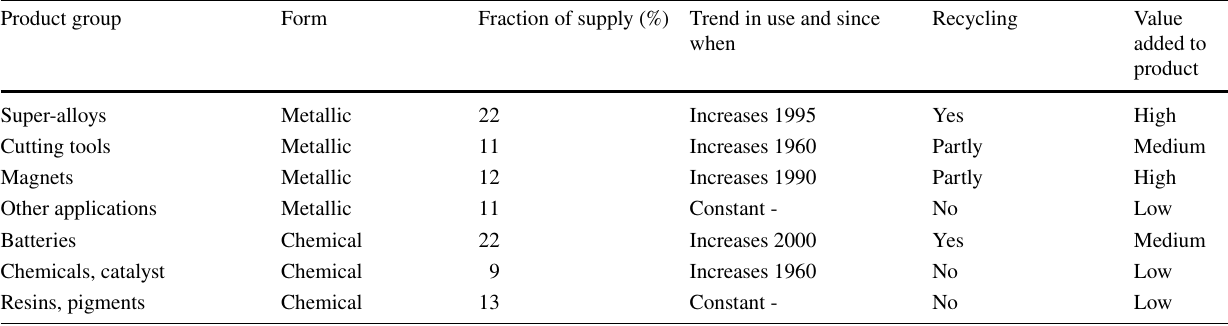
Table 1 Overview of different uses of cobalt [11] Product